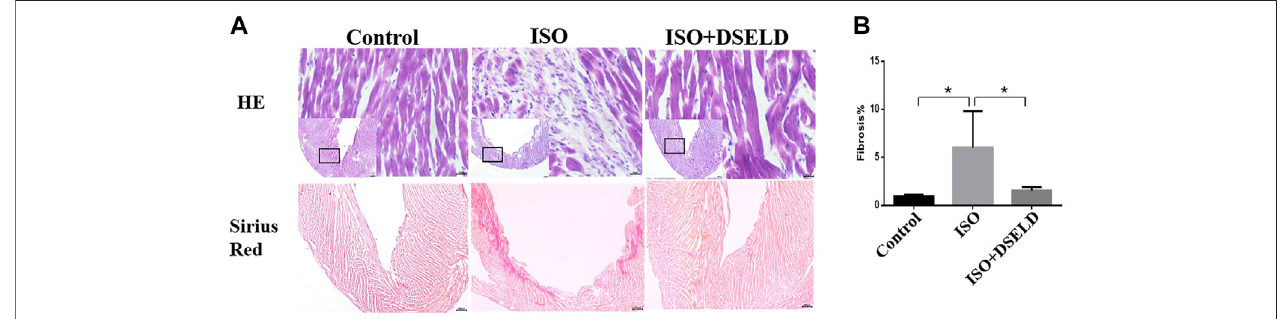
FIGURE 3 | Dangshen Erling decoction (DSELD) protects from myocardial hypertrophy and mitochondrial permeability transition pore (mPTP) in the conditioned media (CM)-induced in fl ammation in H9C2 cells. (A) The operation mode diagram of the RAW264.7 and H9C2 cells. (B) RAW264.7 cells were incubated with lipopolysaccharide (LPS; 1 μ g/ml) with or without DSELD (50 μ g/ml) for 24 h, and nitric oxide (NO) secretion was detected in cell supernatant by ELISA. (C) Representative fl uorescent images of cardiomyocytes from the different groups [green: phalloidin, red: tetramethyl rhodamine methyl ester (TMRM), and blue: DAPI]. (D) Therelativeareawascorrectedbythenucleusandnormalizedtocontrol(F-actin, × 400). (E) The fl uorescenceintensitytocontrol(TMRM, × 200).*p < 0.05,**p < 0.01.